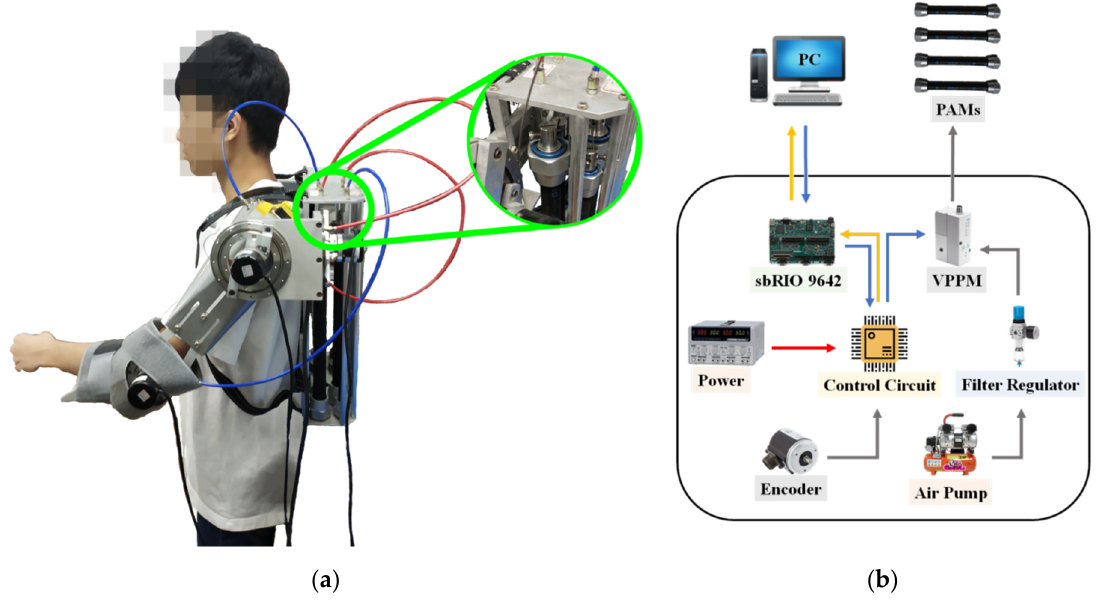
Figure 2. ( a ) Pneumatic muscle actuator (PMA) exoskeleton robot and ( b ) control devices. Table 1. Ranges of motion (ROMs) of four active DOFs.